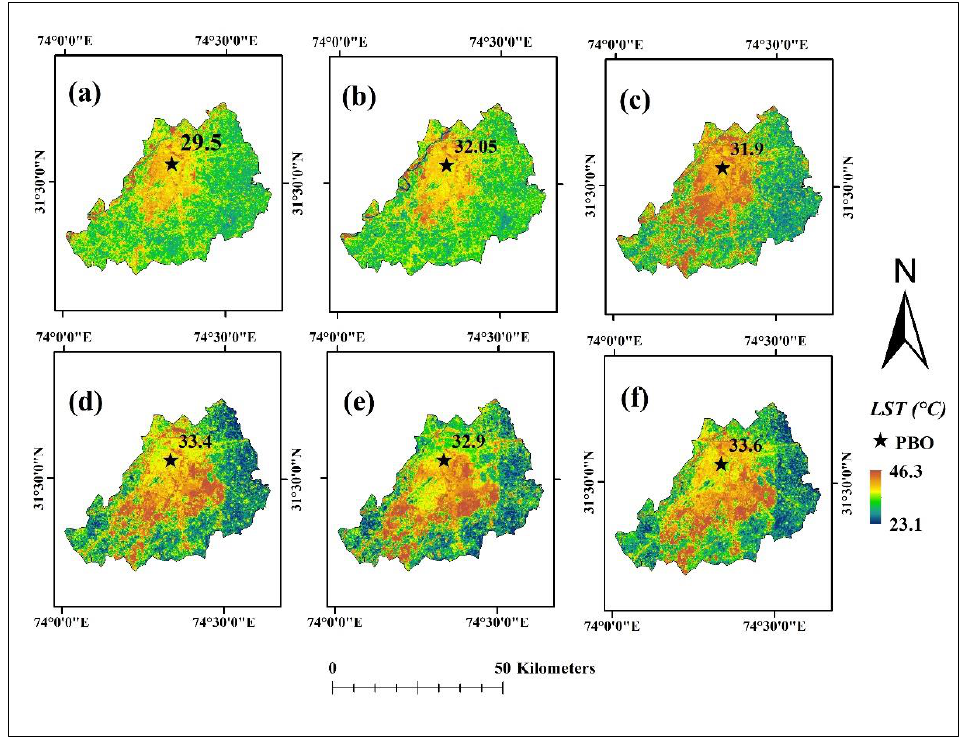
Figure 7. LST (°C) maps of Lahore for years ( a ) 1992, ( b ) 1996, ( c ) 2000, ( d ) 2008, ( e ) 2014, and ( f ) 2020. Star sign indicates the location of weather station.